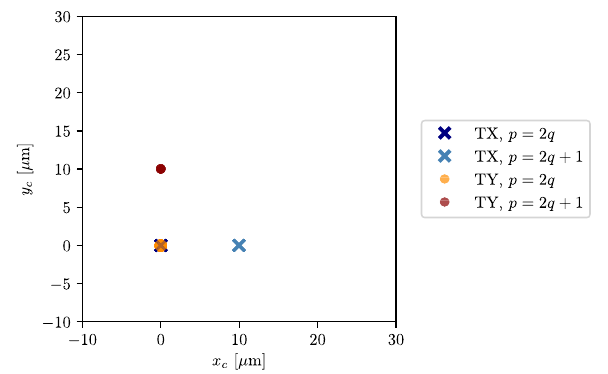
FIG. 23. Simulation of the effect of a 10 μ m solely TX or TY translation misalignment of M2 on the circulation trace at the IP. The even dots ( TY , p ¼ 2 q ) and cross ( TX , p ¼ 2 q ) overlap where p is the path number and q ∈ ½ 0 ; 16 (cid:4) .